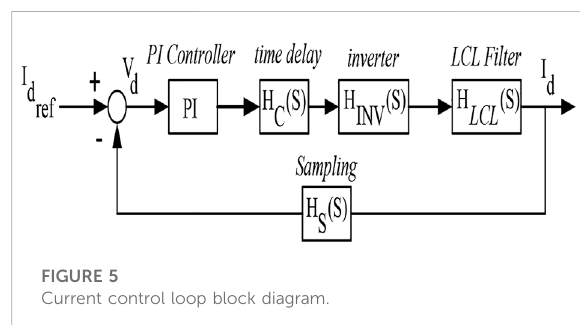
FIGURE 5 Current control loop block